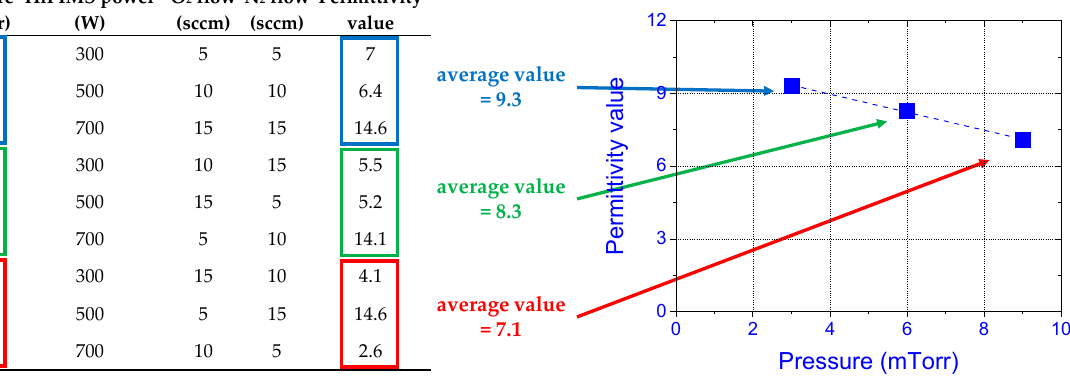
Figure 1. Graphing methodology used in orthogonal tables, employed during the analysis of dependencies between process and material parameters; the example shows the trend (dashed line) of the influence of pressure in the reactive chamber on the permittivity value of HfO x N y films (see Figure 2).